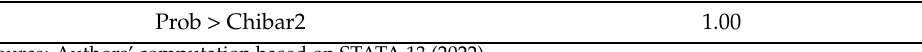
Table 3. Results for Breusch and Pagan test for random